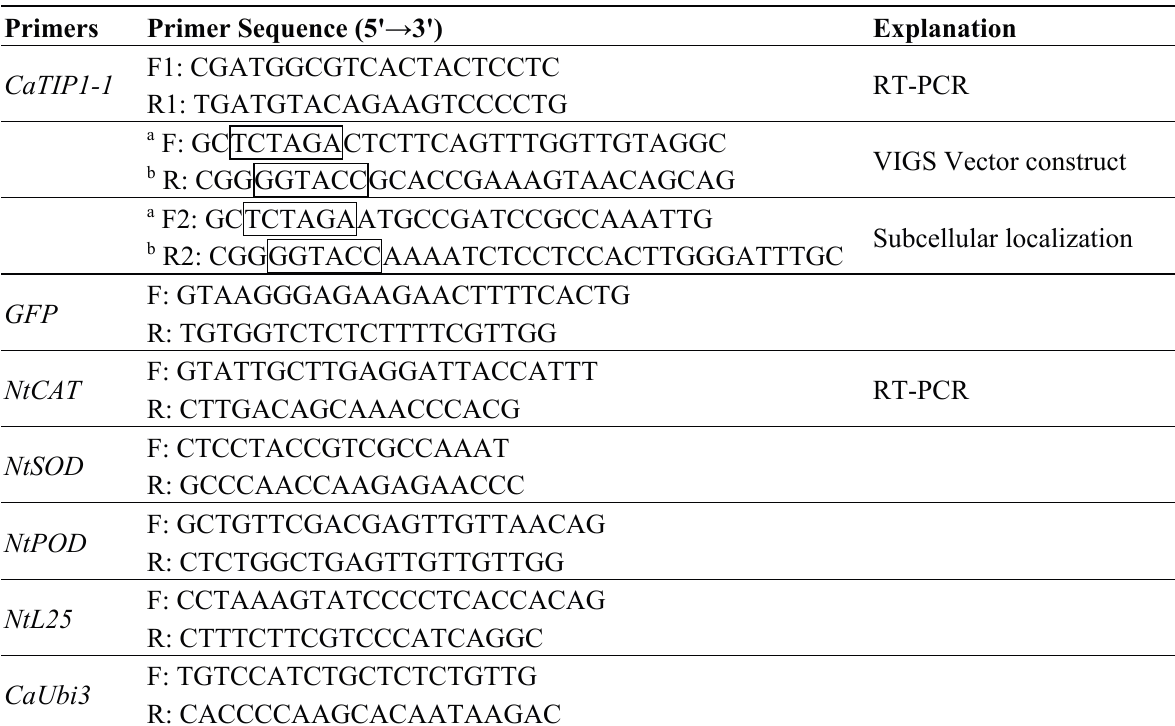
Table 1. Primers used in this